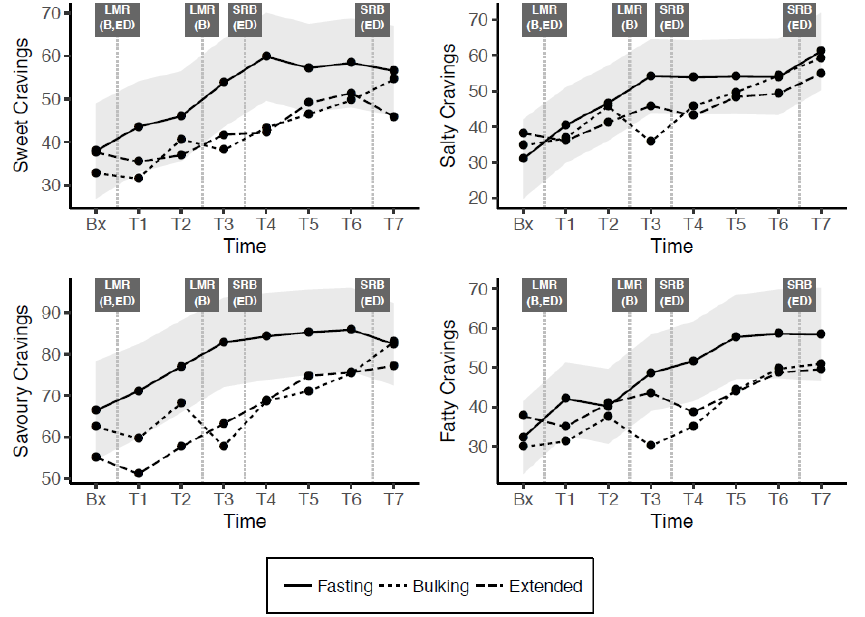
Figure 3. Change across the day in cravings (shaded grey bands indicate 95% confidence interval for difference from fasting condition). Bx = baseline, T= Time(x), LMR = Liquid Meal Replacement, SRB = Snack Replacement Bar, B = Bulking, ED = Extended Distribution.